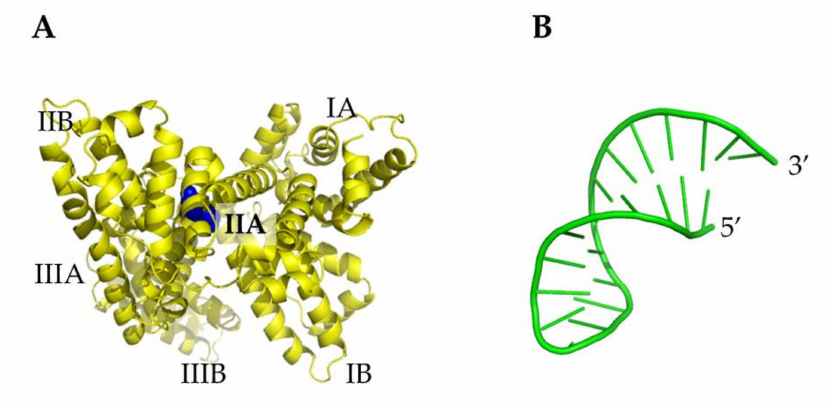
Figure 8. Graphical representation of: ( A ) X-ray structure of HSA monomer (chain A of 1AO6 PDB entry [59]); Trp214 atoms being marked as blue spheres. ( B ) A 3D model of